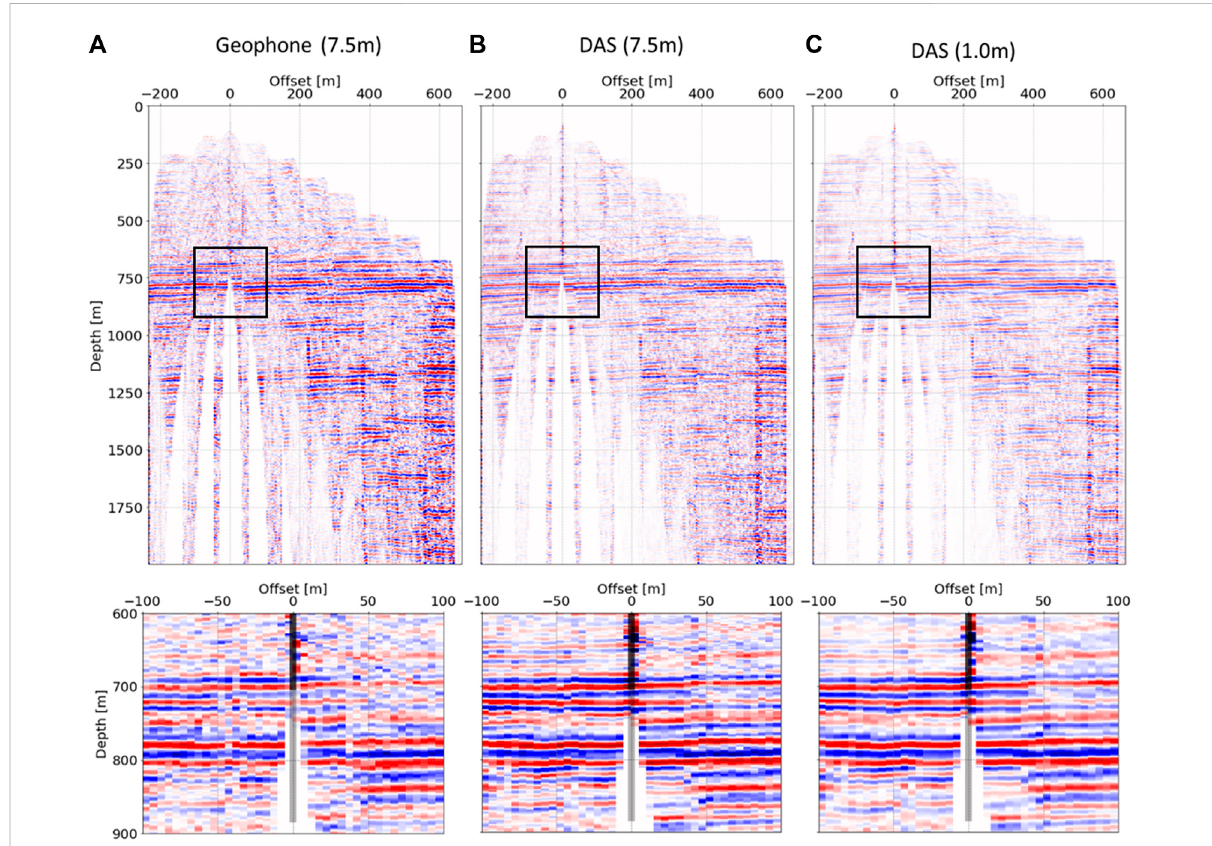
FIGURE 11 Migrated VPS images for 2-D walk away at a test site in Japan. Vz data [ (A) 7.5-m intervals], averaged DAS data [ (B) reduced to 7.5-m intervals], and original DAS data [ (C) 1-m intervals] were used for migration processing. The upper raw image represents a wide area, while the lower image is the enlarged view around the